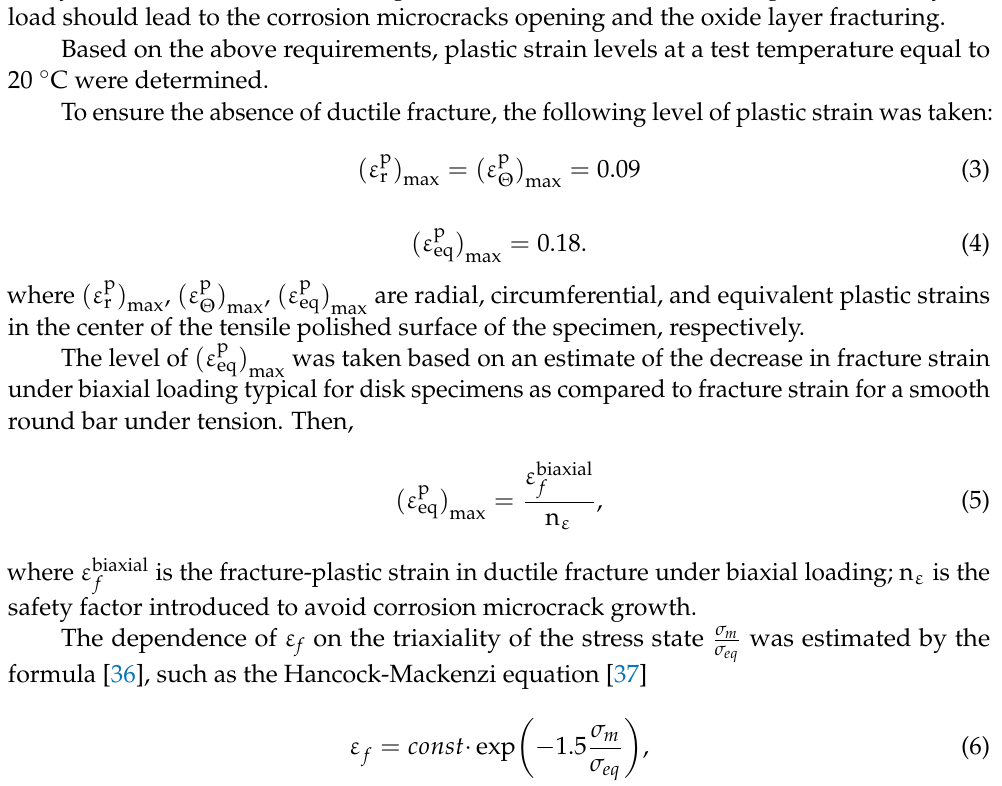
for 12Cr F/M steel irradiated at different temperatures.